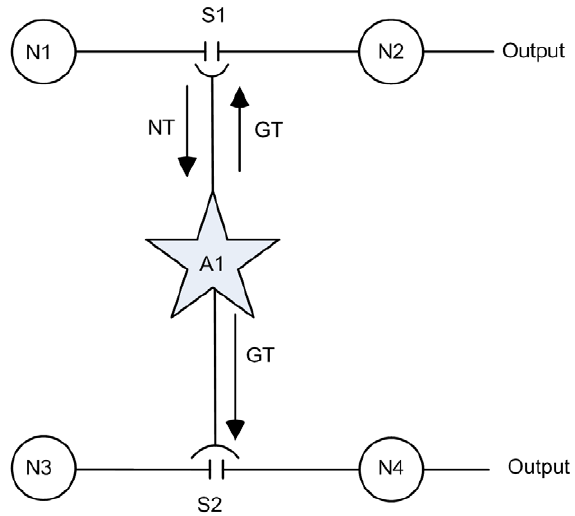
Figure 4. Range of input frequencies producing Ca 2 + oscilla- tions for each mode of operation. The valid ranges of input stimulus frequency which result in sustained Ca 2 + oscillations are 5– 17 Hz for AM, 9–35 Hz for FM and 1–10 Hz for AM-FM.